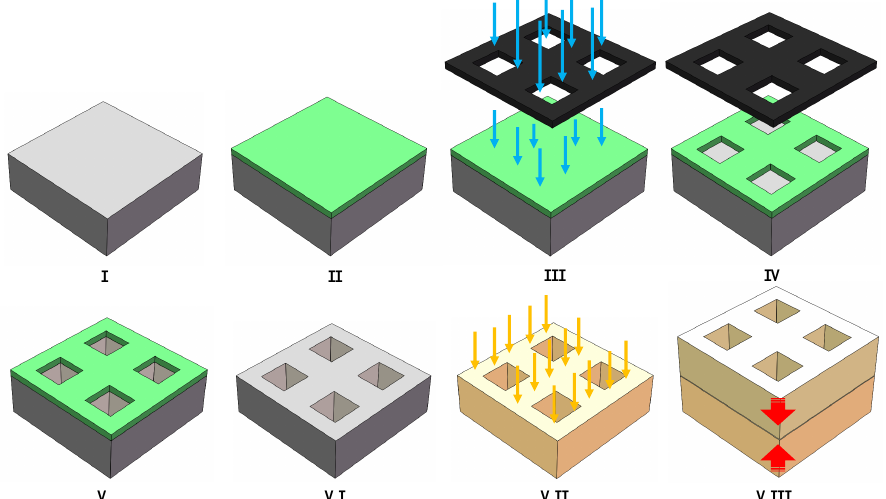
Figure 11. Fabrication process for the MEMS waveguide power divider. Finally, the multi-layer silicon wafer is cut through a wafer dicing system. According to the MEMS process, the power divider was divided into five same- FIG. 2 thickness layers. Figure 12 depicts the geometry of the proposed 16-way power divider.